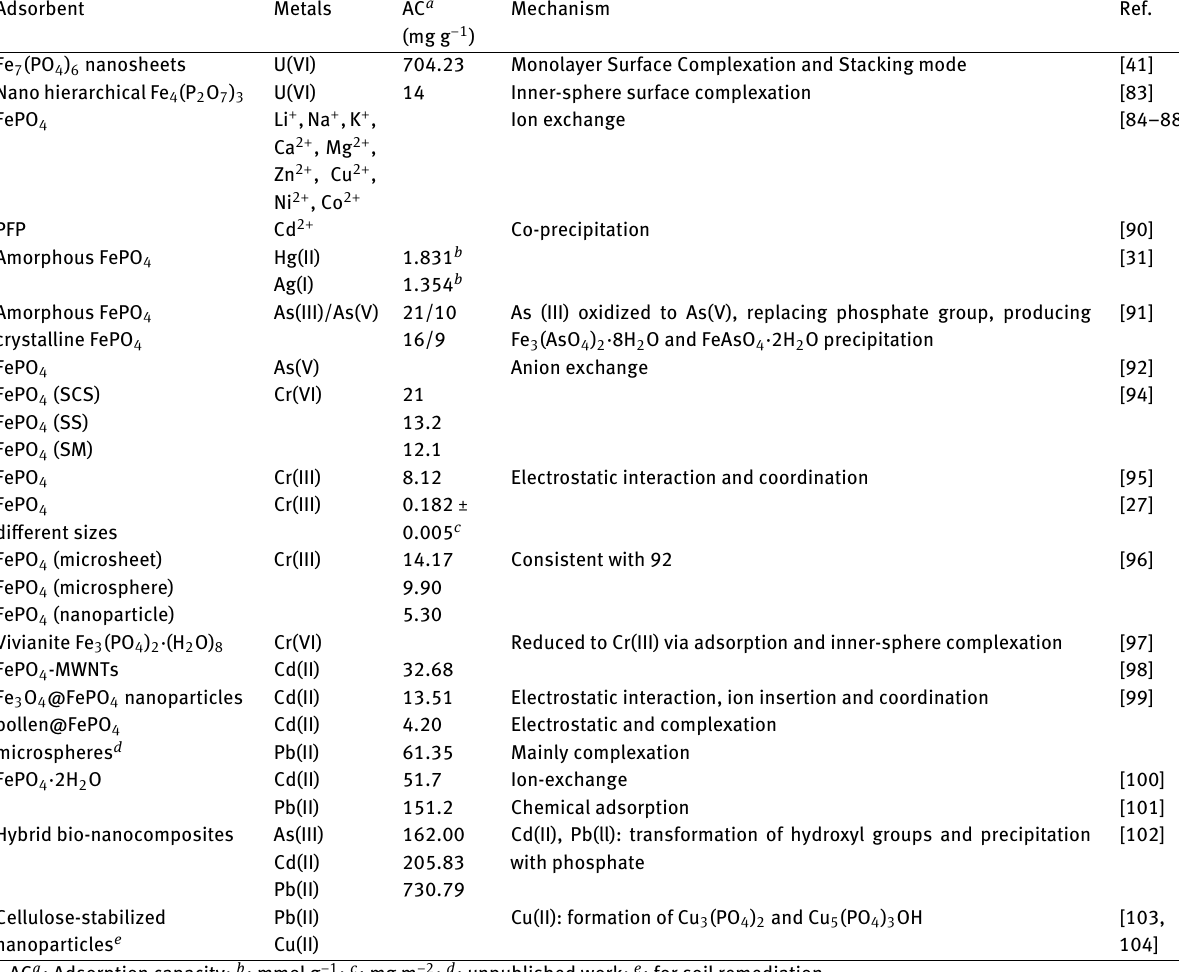
Table 1: Applications of iron phosphate in adsorption, separation and concentration of metals in recent years.